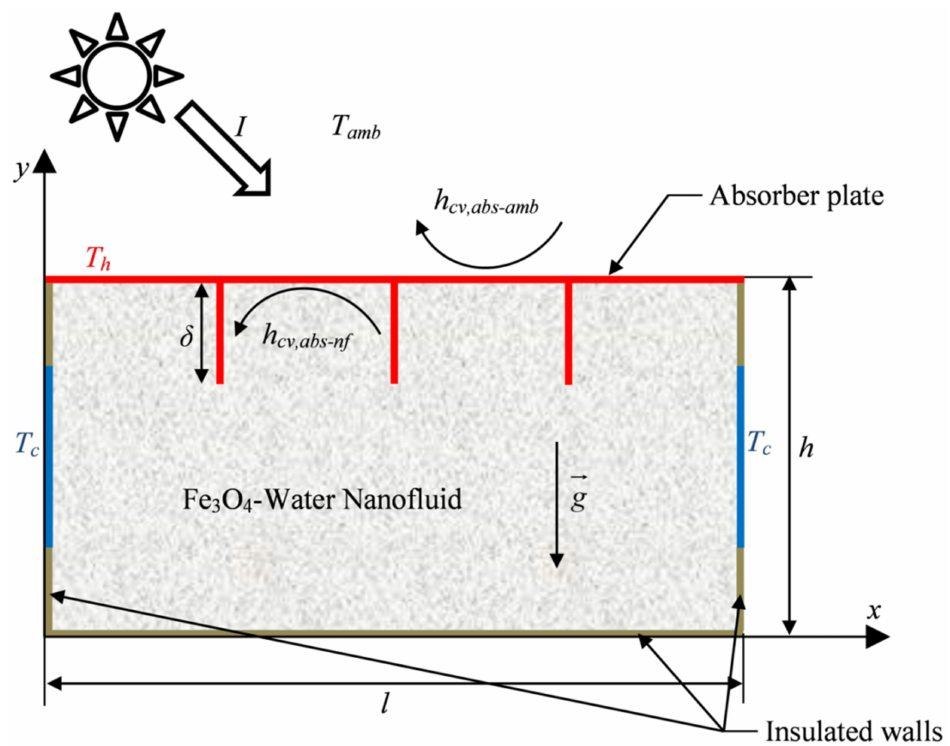
Figure 2. Schematic of the Fe 3 O 4 -Water nanofluid filled 2D rectangular enclosure heated by solar energy using finned absorber